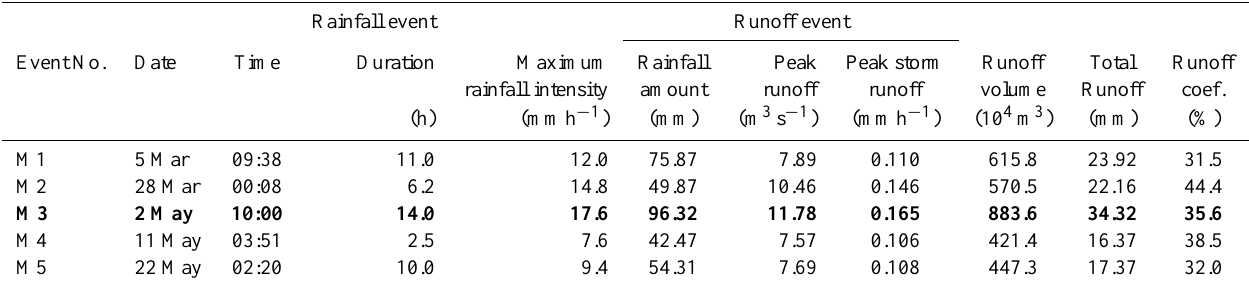
Table 2. Rainfall-runoff events during Itumba’11 season in the Migina catchment (257.4km 2 ). The in-detail investigated event M3 is given in bold.